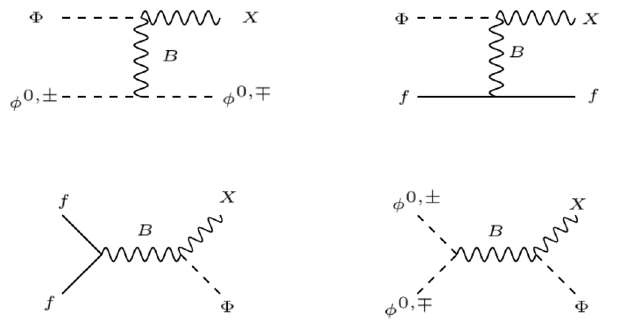
Figure 3 . Annihilations via t -channel (top) and s -channel (bottom) leading to the production of VDM X before EWSB. The diagrams with Goldstone bosons identically vanish, leaving only two diagrams with SM fermions.